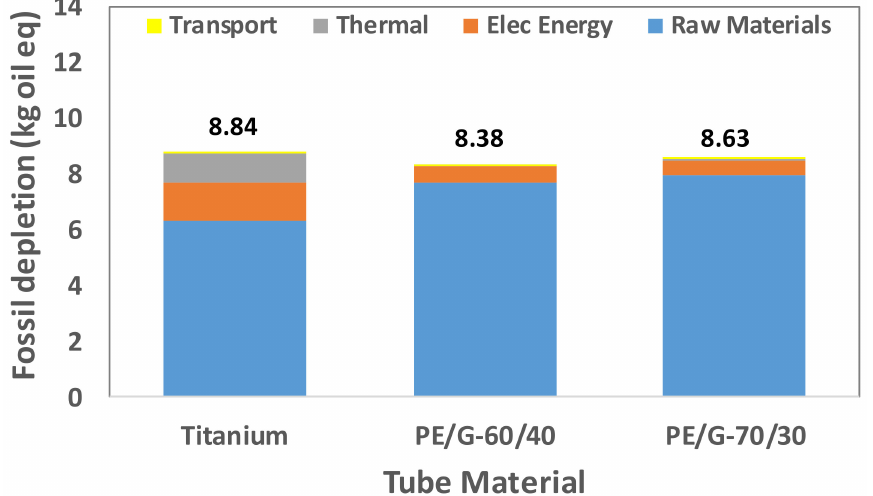
Figure 13. Fossil depletion for titanium and polymer